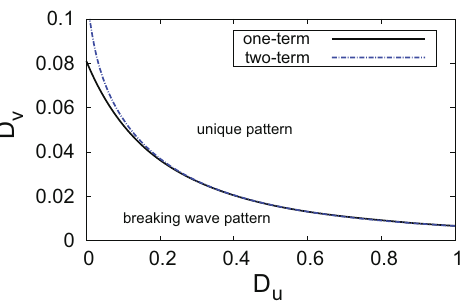
Figure 4: The D D − u v parameter plane shows the degenerate hysteresis curve which separates the domains of di ff erent steady state patterns. The parameters are fi xed as δ